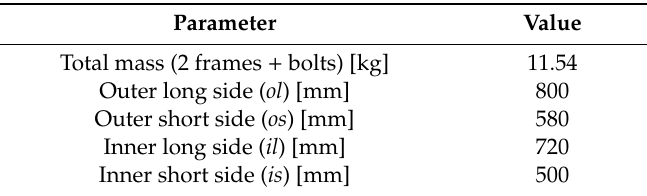
Figure 2. Experimental setup: ( a ) schematic of the steel frame and of the excitation / measurement nodes; ( b ) photo of the specimen PN excited by the shaker at node in1 . Table 3. Properties of the steel